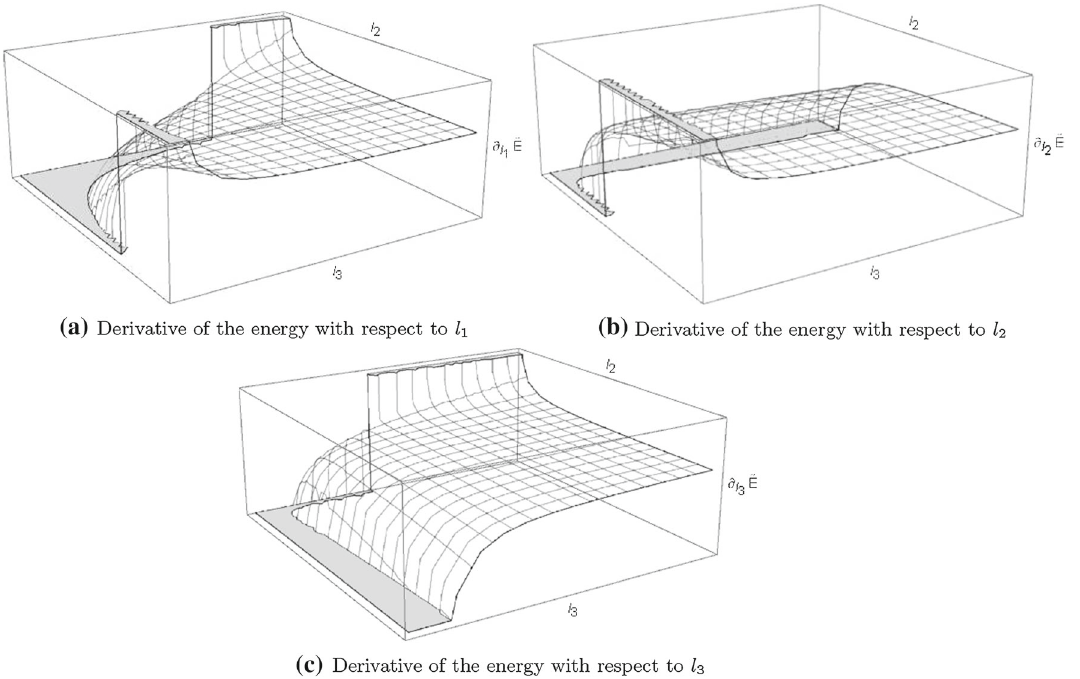
assume larger values l i